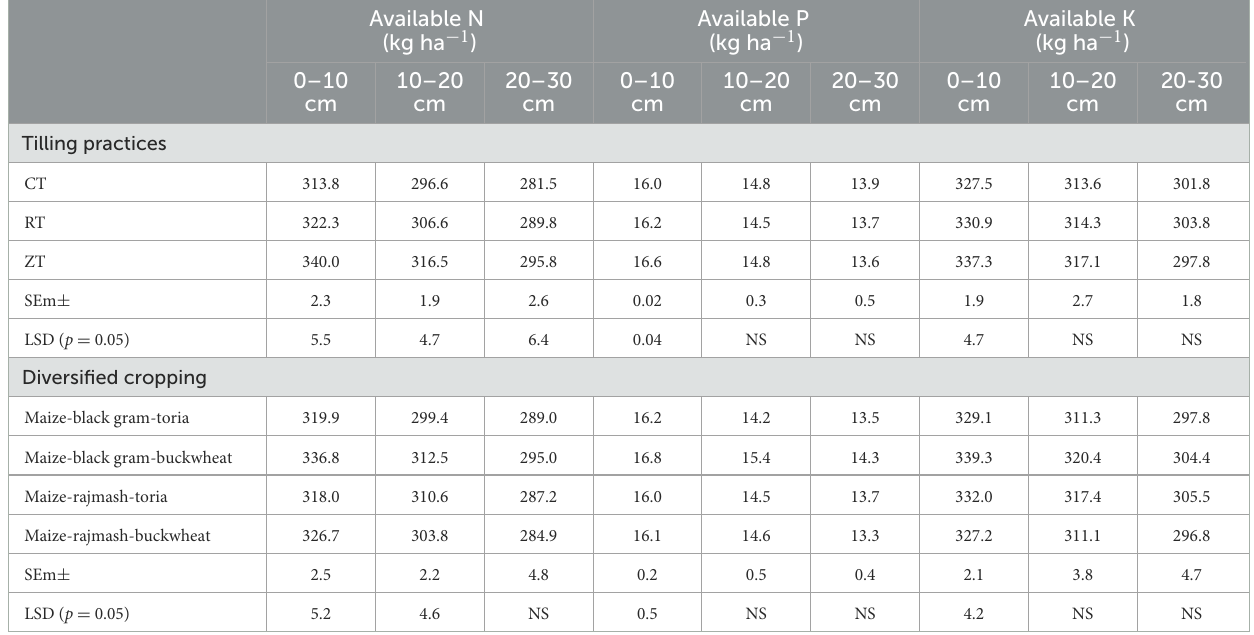
TABLE 3 Impact of different tillage practices and diversified cropping on available N, P, and K after three cropping cycles. Available N Available